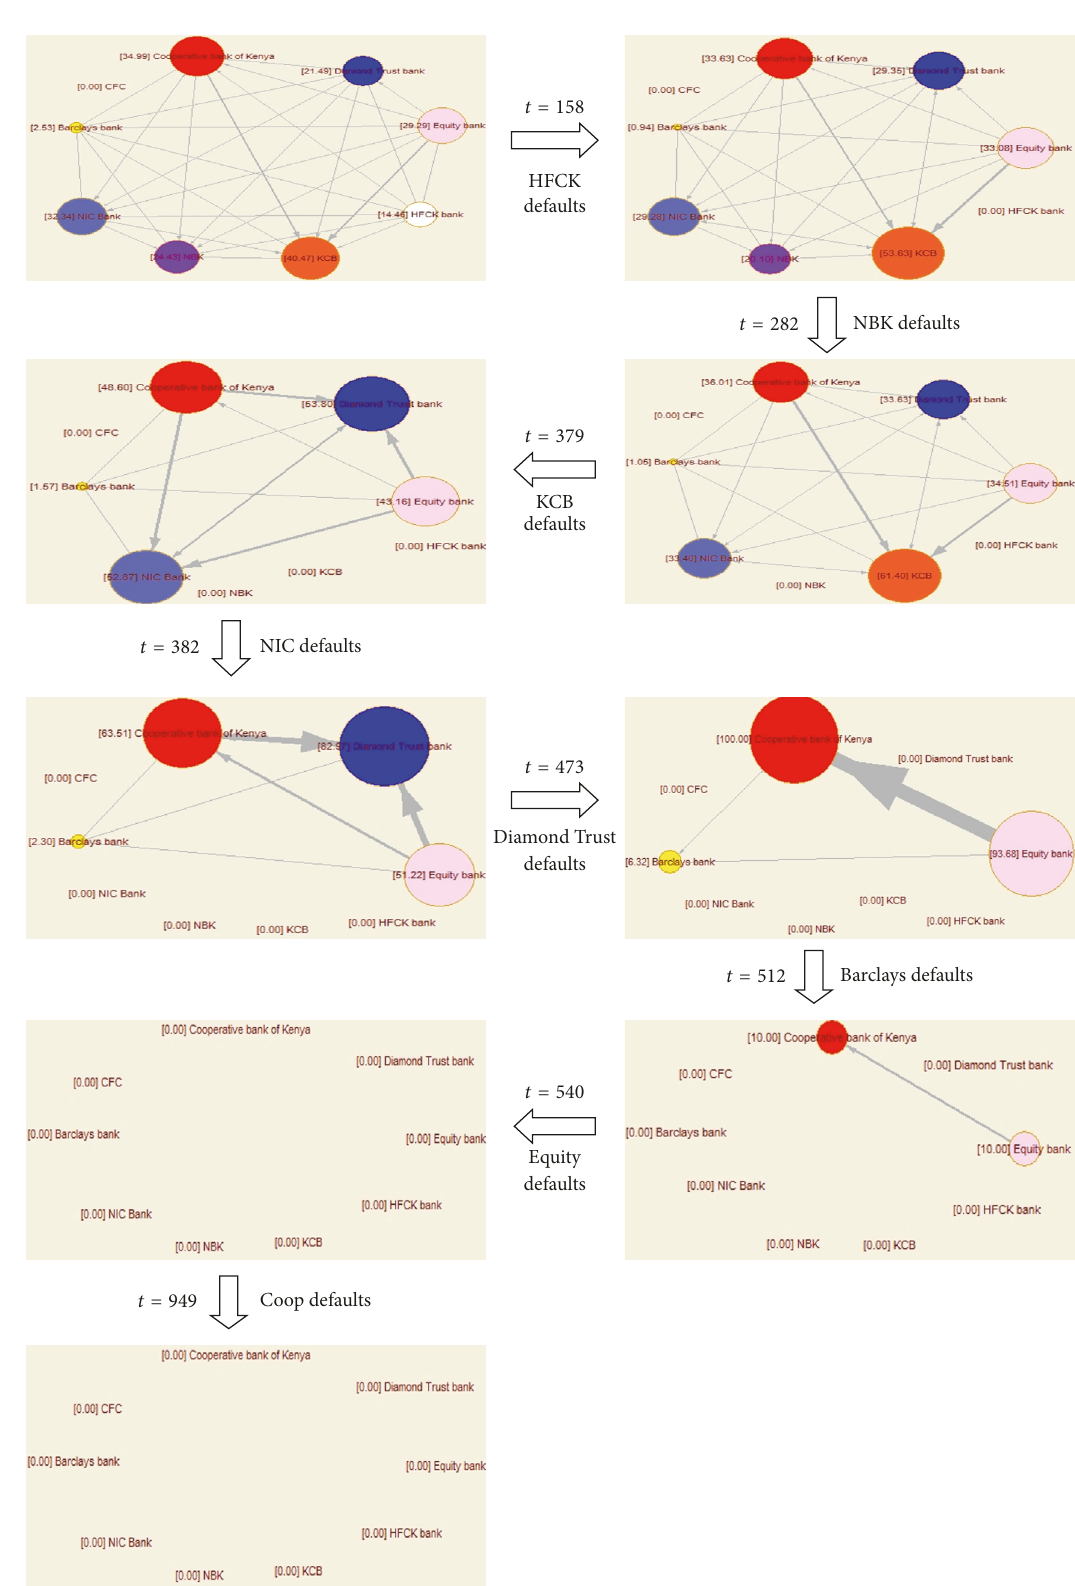
Figure 5: The evolution of the network topology in 2015 estimated by maximum entropy; the size of each node represents the total percentage of in-strength and out-strength of each bank and the number of size is marked beside each